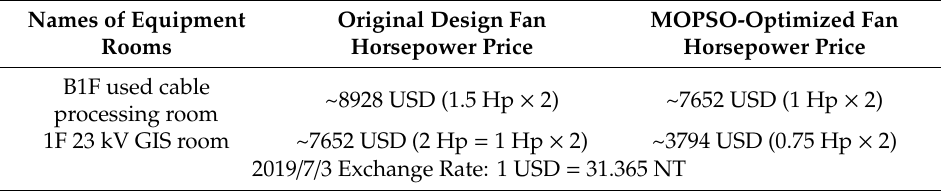
Table 6. Benefit analysis of equipment cost reduction in the MOPSO-optimized exhaust